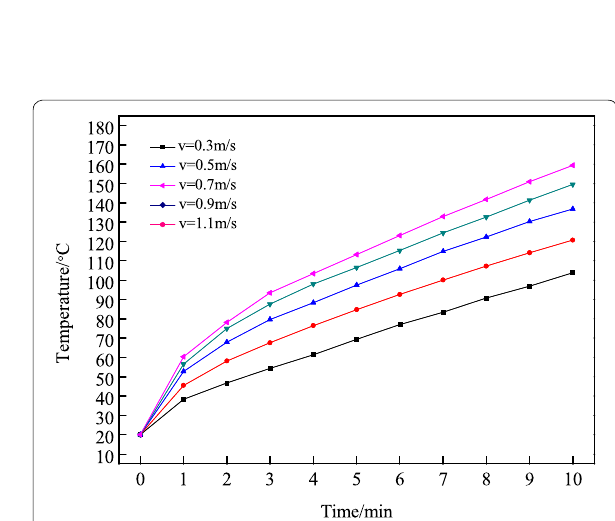
Figure 11 Calculated temperature curve under different